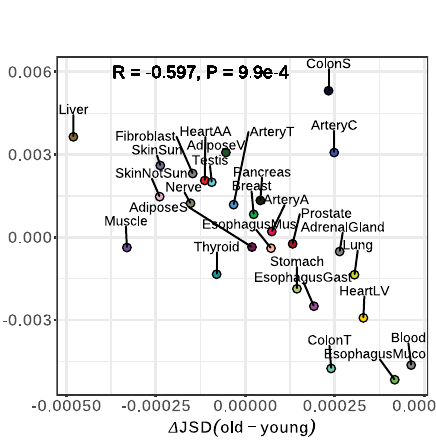
c Consistency of measuring the average age-associated change in gene expression heterogeneityacrossatissueusingabinarybinningstrategy(y-axis, JSD old - JSD young ) or a 6 bin strategy (x-axis, slope of JSD across 6 age bins). R indicates Pearson correlation value. d The relationship between gene expression heterogeneity and the difference in expression heritability between old and young individuals. R and p-value are obtained from two-sided Pearson correlation